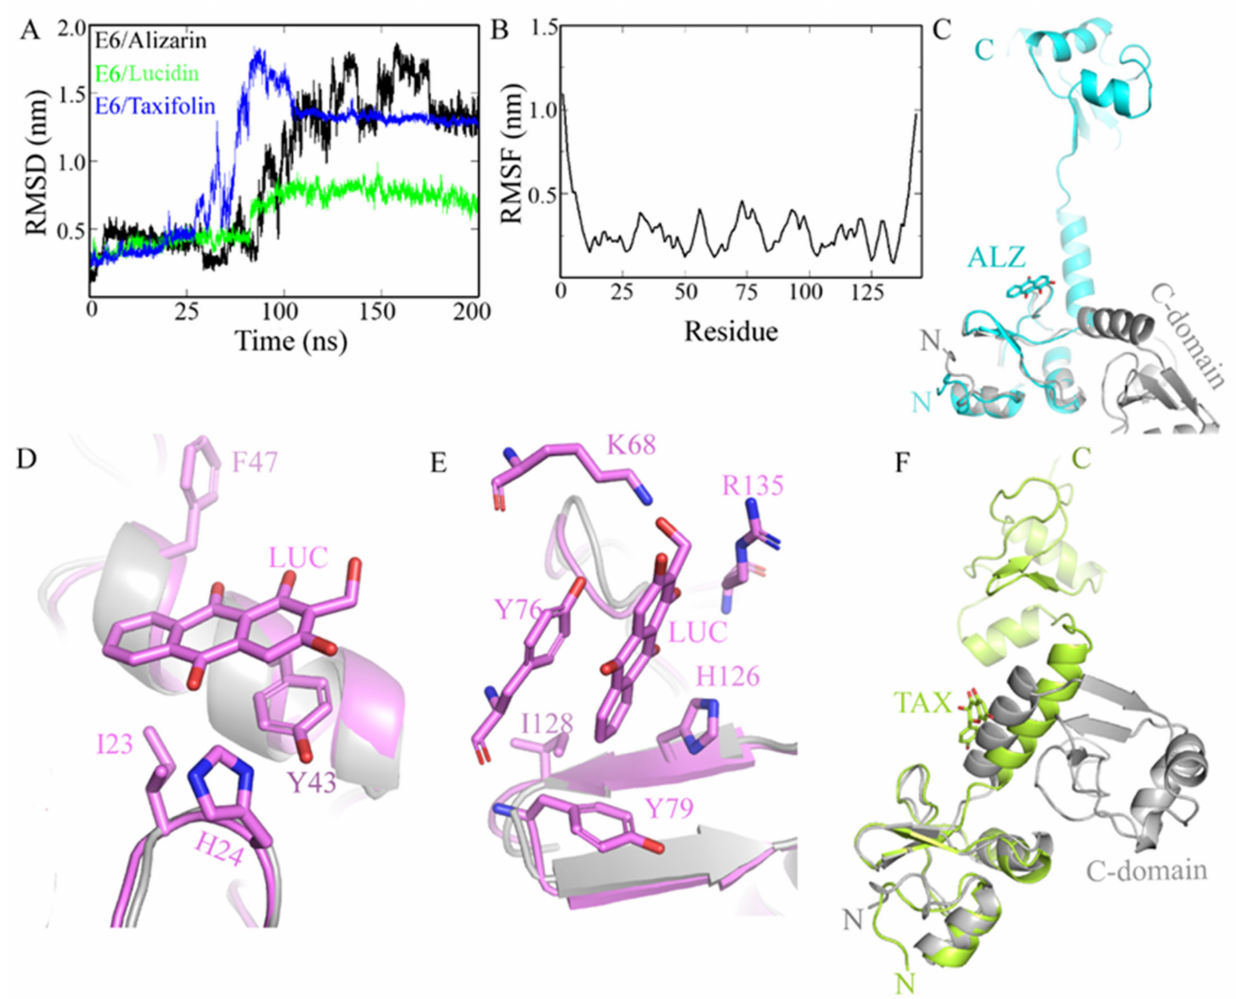
Figure 2. MD simulation study of E6/alizarin/lucidin/taxifolin complexes. ( A ) Root-mean-square deviation (RMSD) of E6 complexes. E6/lucidin complex is the most stable complex. ( B ) Root-mean- square fluctuations (RMSF) of E6/lucidin complex. ( C ) Trajectory analysis of E6/alizarin complex suggests that both N- and C-domain (cyan) move away from the initial structure (grey). Lucidin binds E6 at two sites. ( D ) Site I at N-domain; lucidin interacting residues are shown. ( E ) Site II at C- domain; lucidin residues that interact shown as stick representation. Simulated structure is shown in violet whereas the original structure is in grey. ( F ) During simulation, E6 adopts an extended conformation. Simulated structure is shown in lime-green whereas the original structure is in